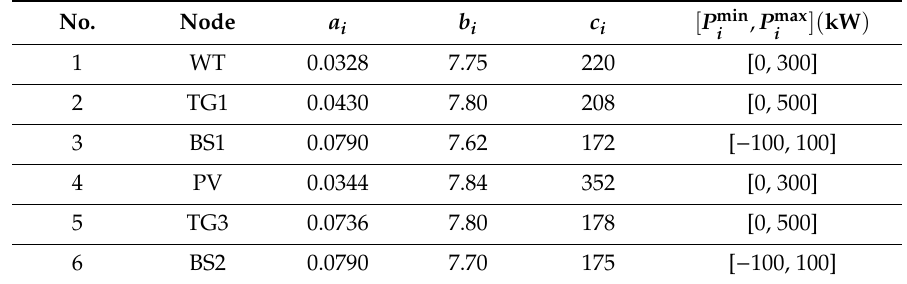
Table 2. Microgrid system operating